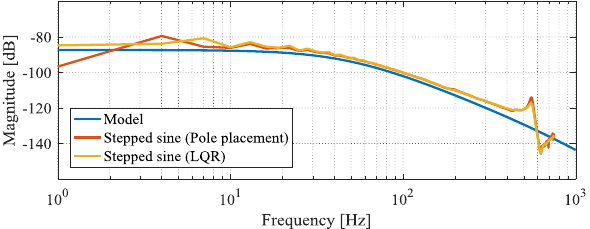
Figure 12: Frequency response plot where the result of the experimental identification with the stepped sine method is compared with the rigid body rotor model. The experimental result shows the first flexible mode peak.